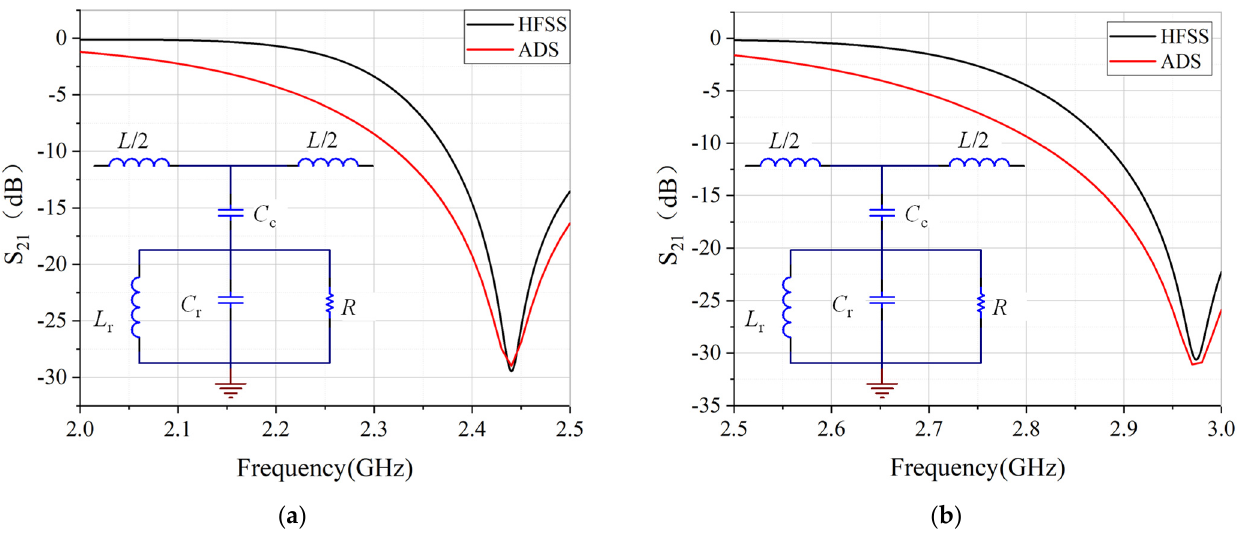
Figure 3. The simulated transmission results of ( a ) Rectangular rings; and ( b ) Circular rings. The insets are their corresponding equivalent circuit models.